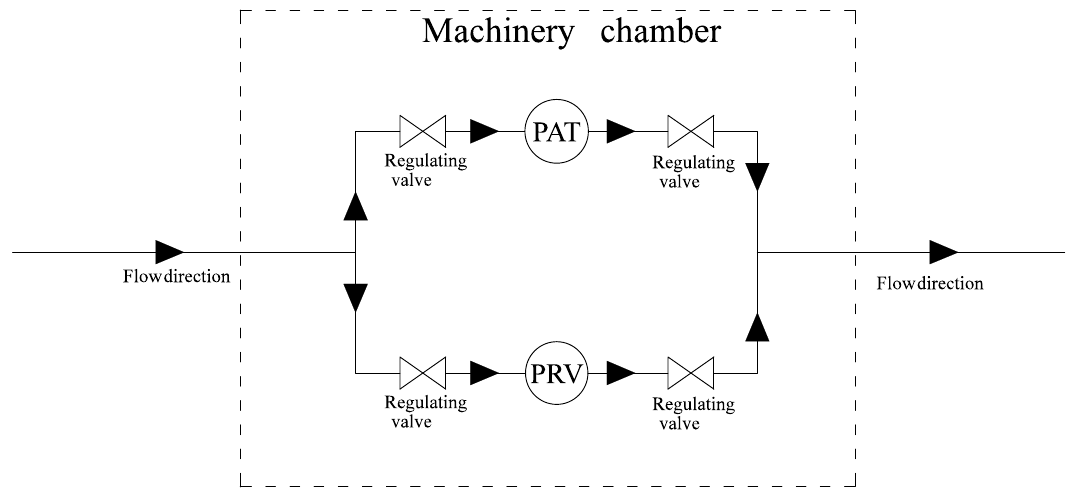
Figure 1. Installation scheme of a coupled system of pumps as turbine (PAT) and pressure reduction valve (PRV).